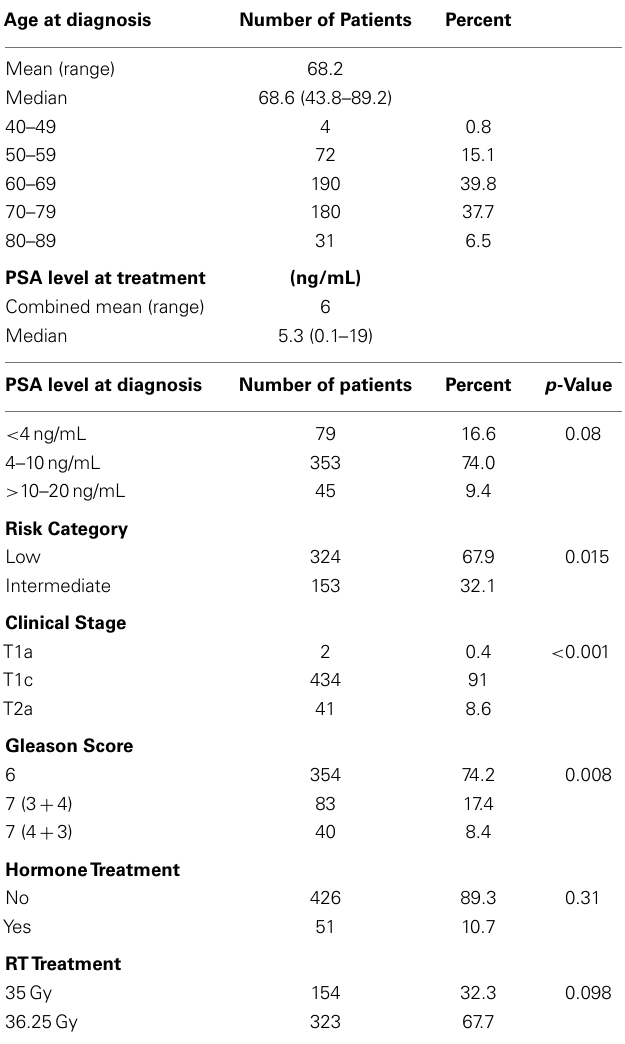
3 + 4 = 7, though p -value trended toward significance ( p = 0.058) ( Figure 7 ). MULTIVARIATE ANALYSIS Results of Cox multivariable regression analysis are shown in Table 2 . Pretreatment risk factors analyzed included